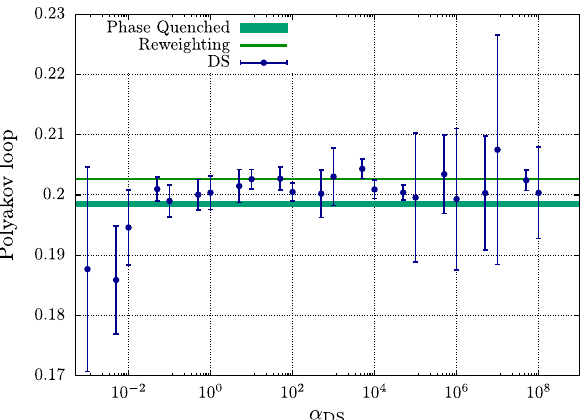
Fig. 4 The Langevin time evolution of the Polyakov loop using gauge cooling (top) and dynamic stabilisation (bottom) for HDQCD on a 8 3 × 20lattice,with κ = 0 . 04, β = 5 . 8and μ = 2 . 45.AfterashortLangevin time ( θ ≈ 20) the Polyakov loop changes its behaviour when DS is not used